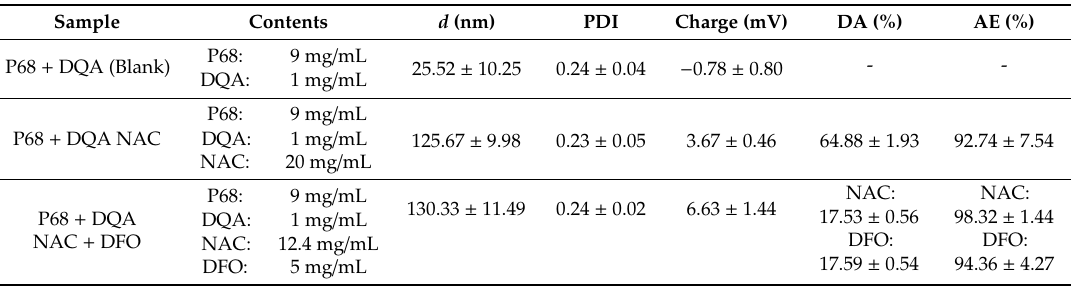
Table 1. Hydrodynamic diameter (d), polydispersity index (PDI), surface charge, drug association (DA) and association e ffi ciency (AE) of blank and drug-associated P68 + DQA nanoformulations prepared at 80 ◦ C (mean ± S.D., n =